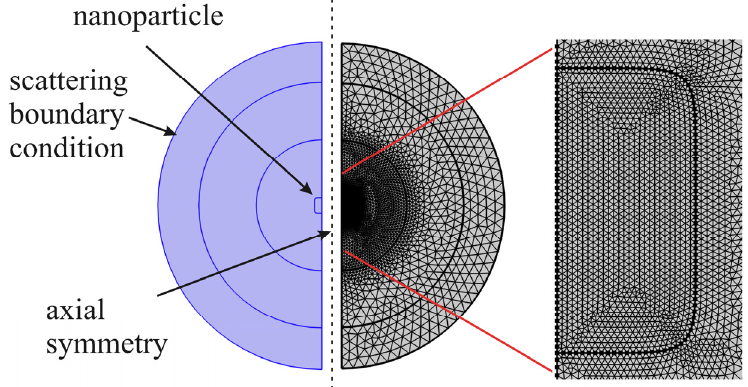
Figure 4. Geometry and a mesh of the Comsol simulation.